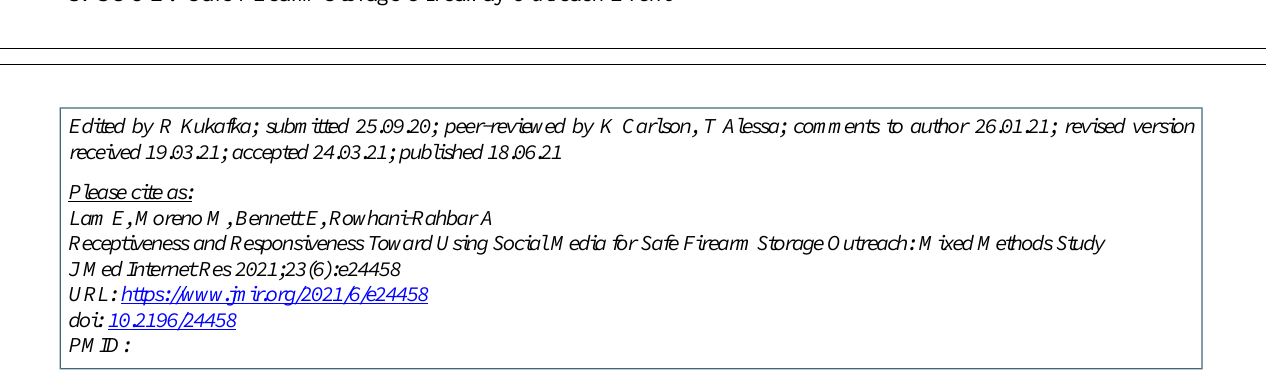
RUCC: Rural-Urban Continuum Code SFSGOE: Safe Firearm Storage Giveaway Outreach